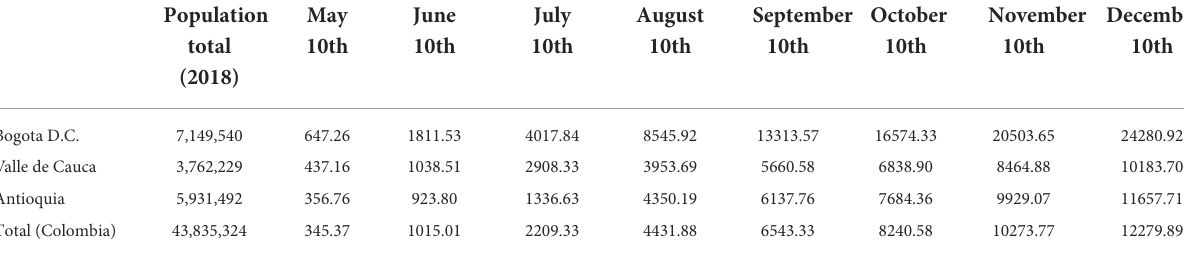
TABLE 1 Number of COVID-19 PCR tests per 100,000 inhabitants, by